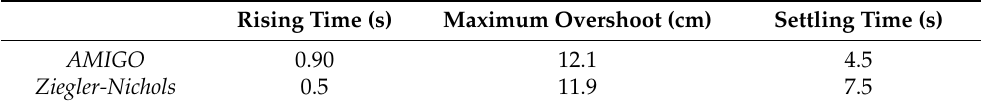
Table 10. The rising time, maximum overshoot, and settling time for the step response with an additional load of 6.1 g.